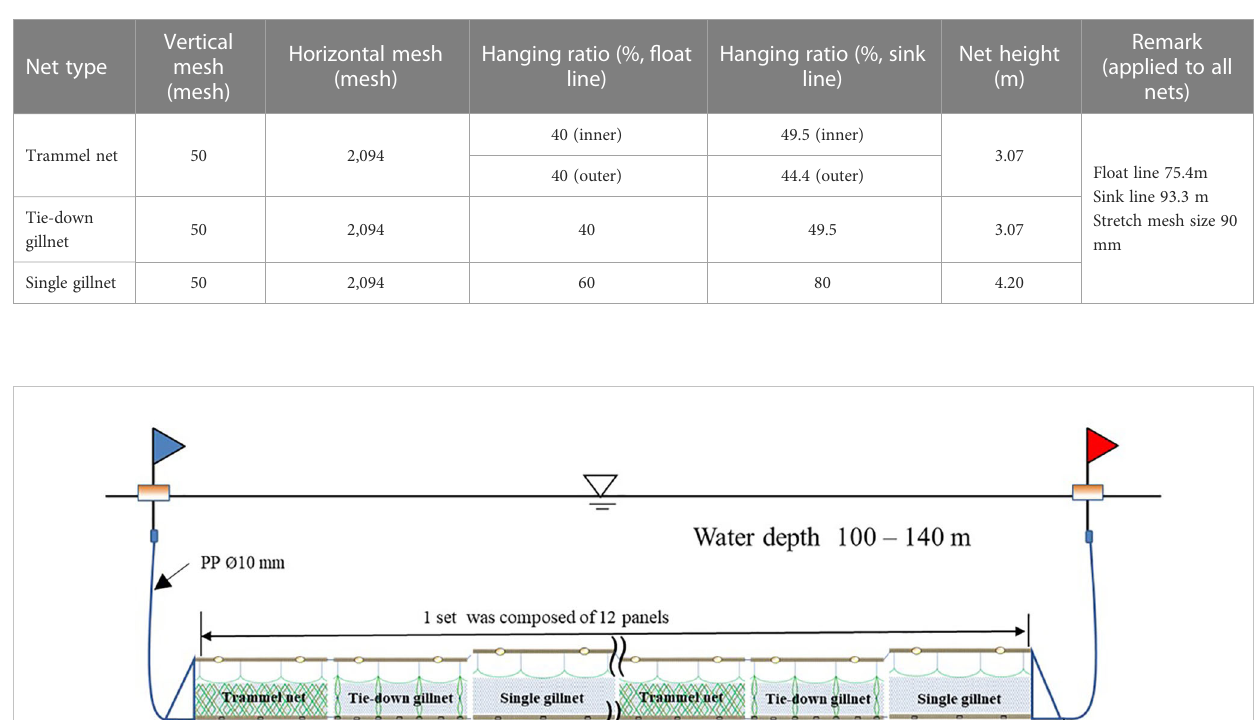
TABLE 1 Composition of the experimental gillnets for comparison of fi shing performance.